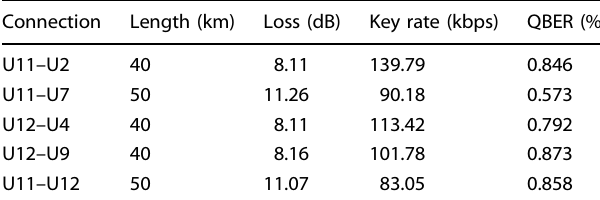
Table 3. QKD key rates and QBERs between new users U11 and U12 and original users in the network and between U11 and